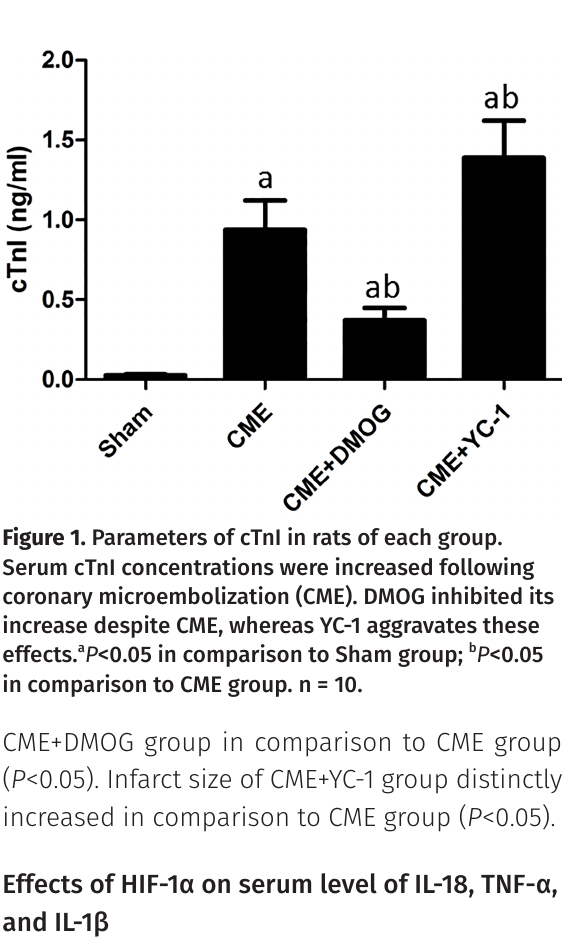
Fig. 4 indicates: 1) Myocardial levels of Caspase-1,